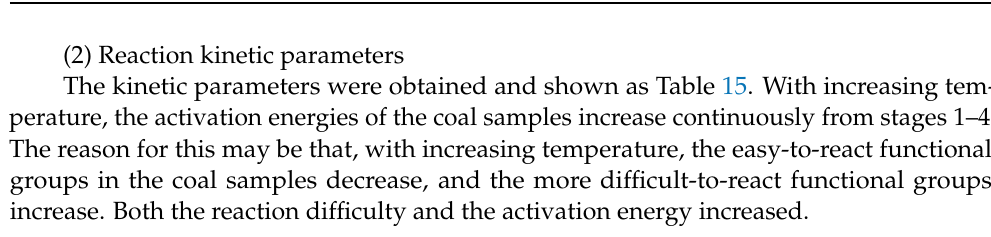
Table 15. Reaction kinetic parameters of Kerjian